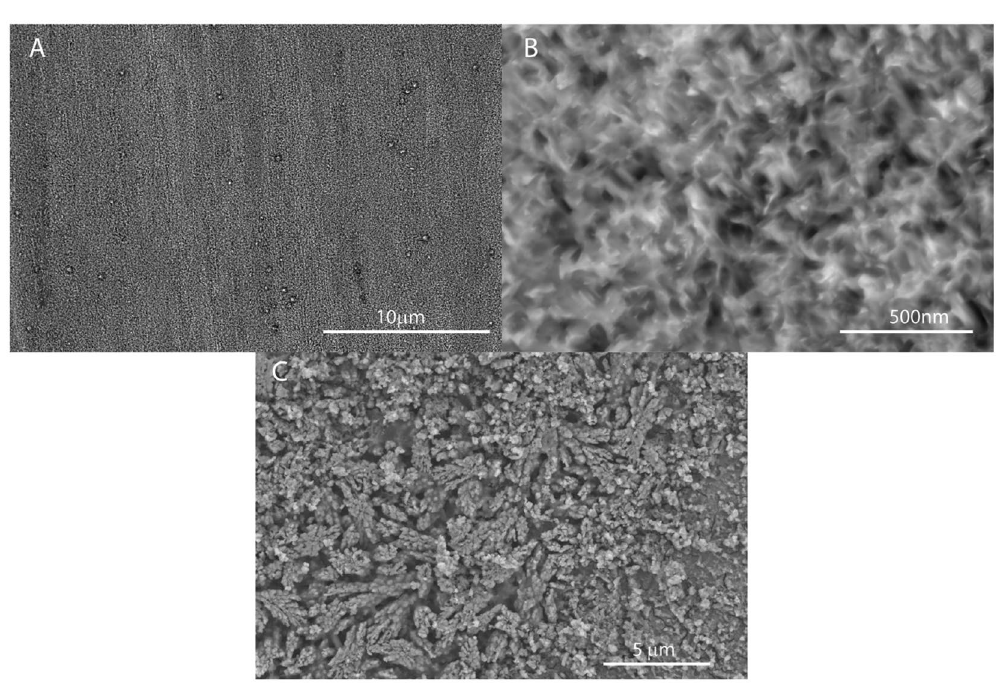
Figure 9. Scanning electron microscopy (SEM) of VA-MoS 2 #1 after 10